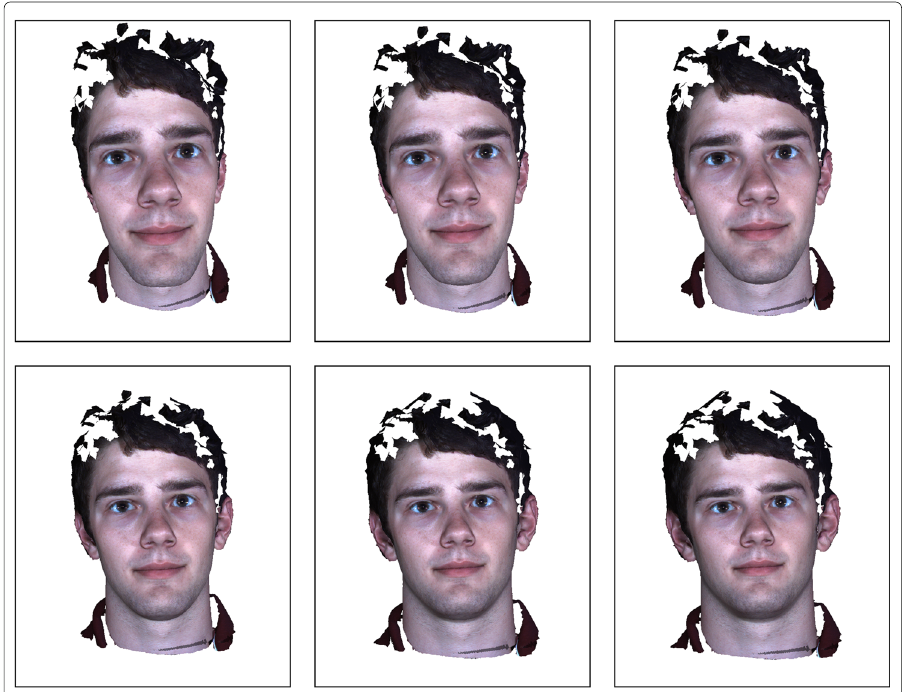
Fig. 4 Camera focal lengths: First row from left to right: 24 mm, 28 mm, and 35 mm; second row from left to right: 50 mm, 85 mm, and 135